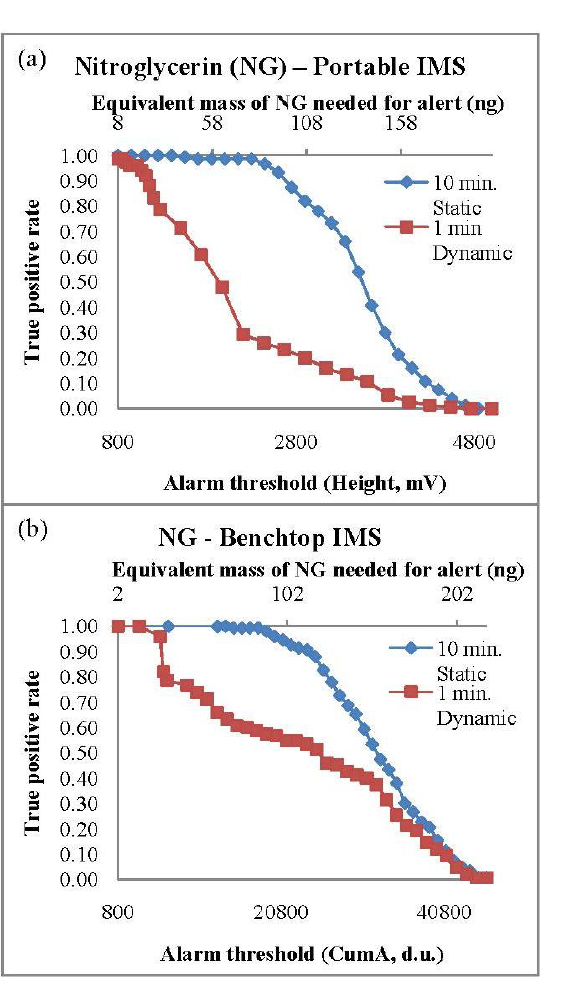
Figure 1. True positive rates for the ( a ) portable and ( b ) benchtop IMS systems. Comparison of true positive rates for the two extraction methods are shown with varying alarm